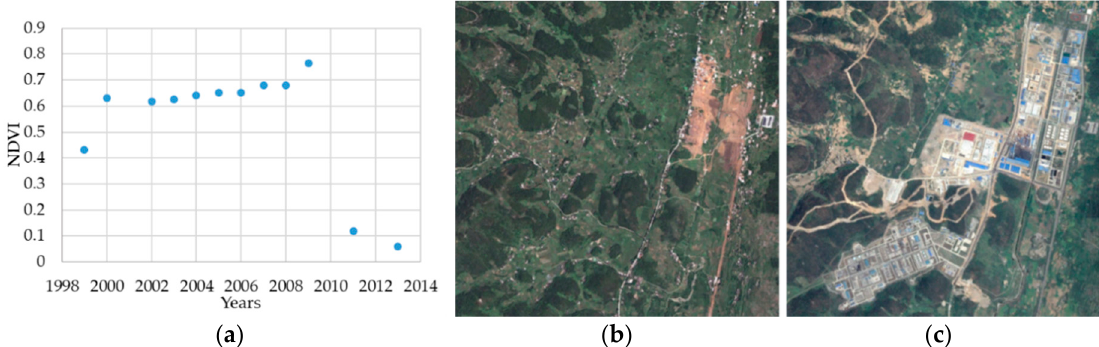
Figure 7. Forest attenuation caused by land use change: ( a ) NDVI trend in the sample area; ( b ) Image of the sample area acquired on August 3, 2010; ( c ) Image of the sample area acquired on March 25, 2015.